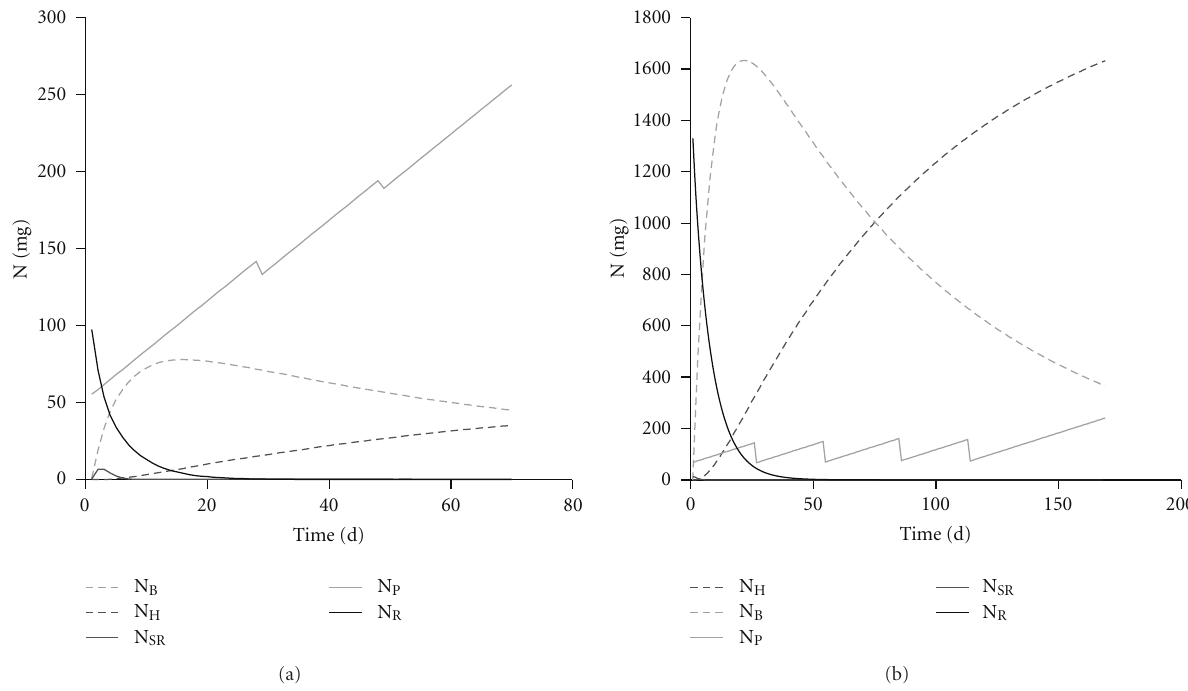
Figure 5: Simulated evolution of the N pools in (a) the residue application experiment (RA), and (b) the full interaction experiment (FI). Note that inorganic N from the residue (N SR ) remains close to zero for most of the time in both experiments as it is quickly absorbed by plant or microbial